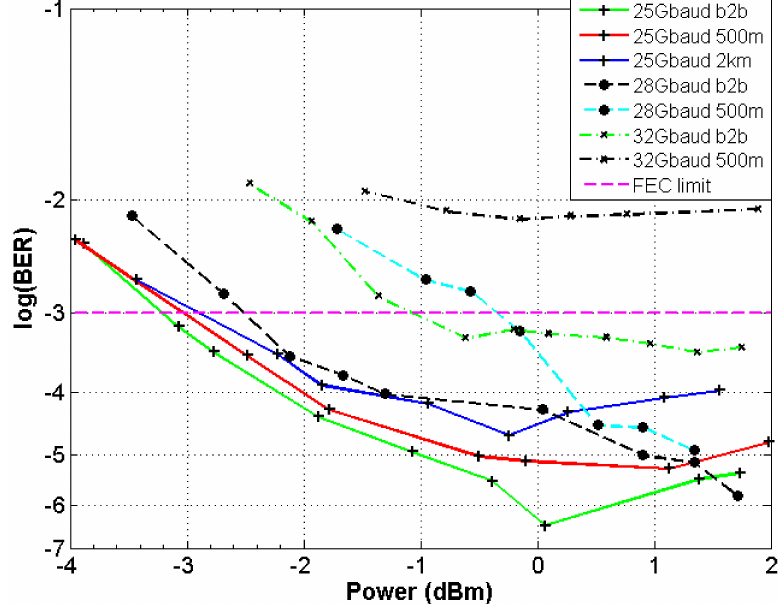
Figure 9. BER curves at 25, 28, and 32 Gbaud for back-to-back configuration and propagation in 500 m and 2 km of a standard single-mode